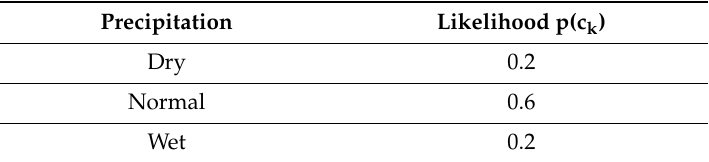
Table 6. Statistics of precipitation in